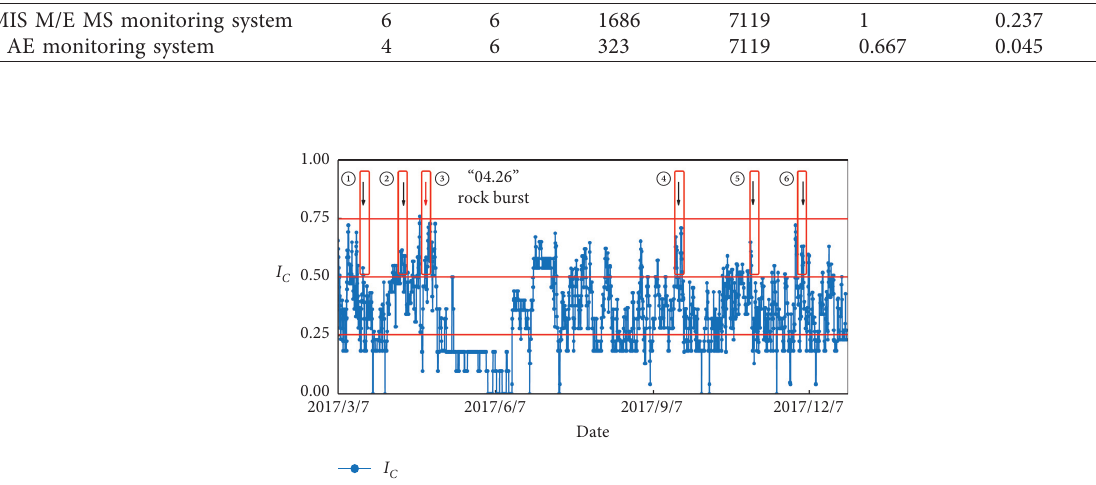
Figure 11: Multisystem and multiparameter integrated early warning index of rock burst risk.